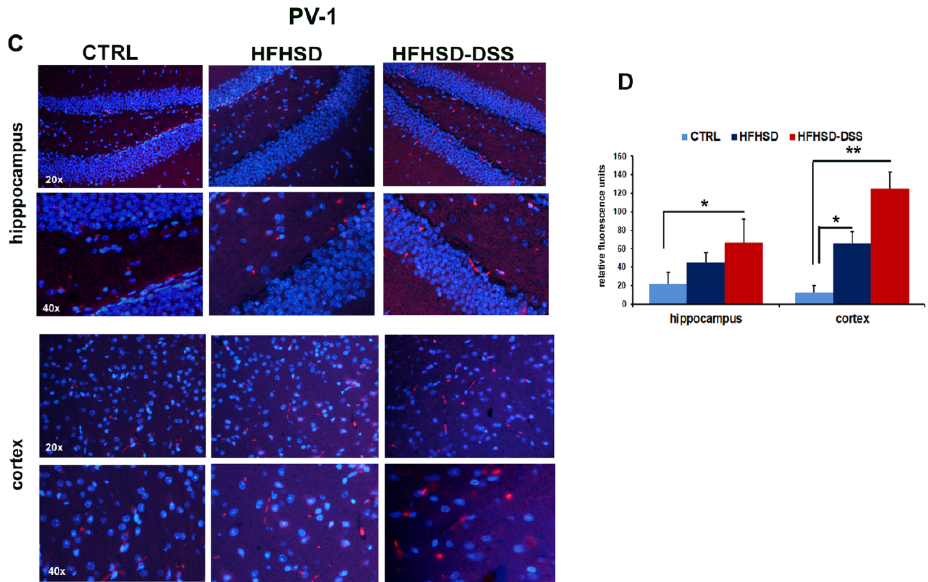
Figure 7. Representative images of Occludin ( B ) and PV-1 ( C ) immunofluorescence in hippocampus and cortex of both treated groups and control. Quantitative analysis of immunofluorescence detection of Occludin ( A ) and PV-1 ( D ) and in the hippocampus and cortex of both treated groups compared to controls; each value is presented as the mean ± SD for seven mice. Statistical significance: * p < 0.05; ** p < 0.01.